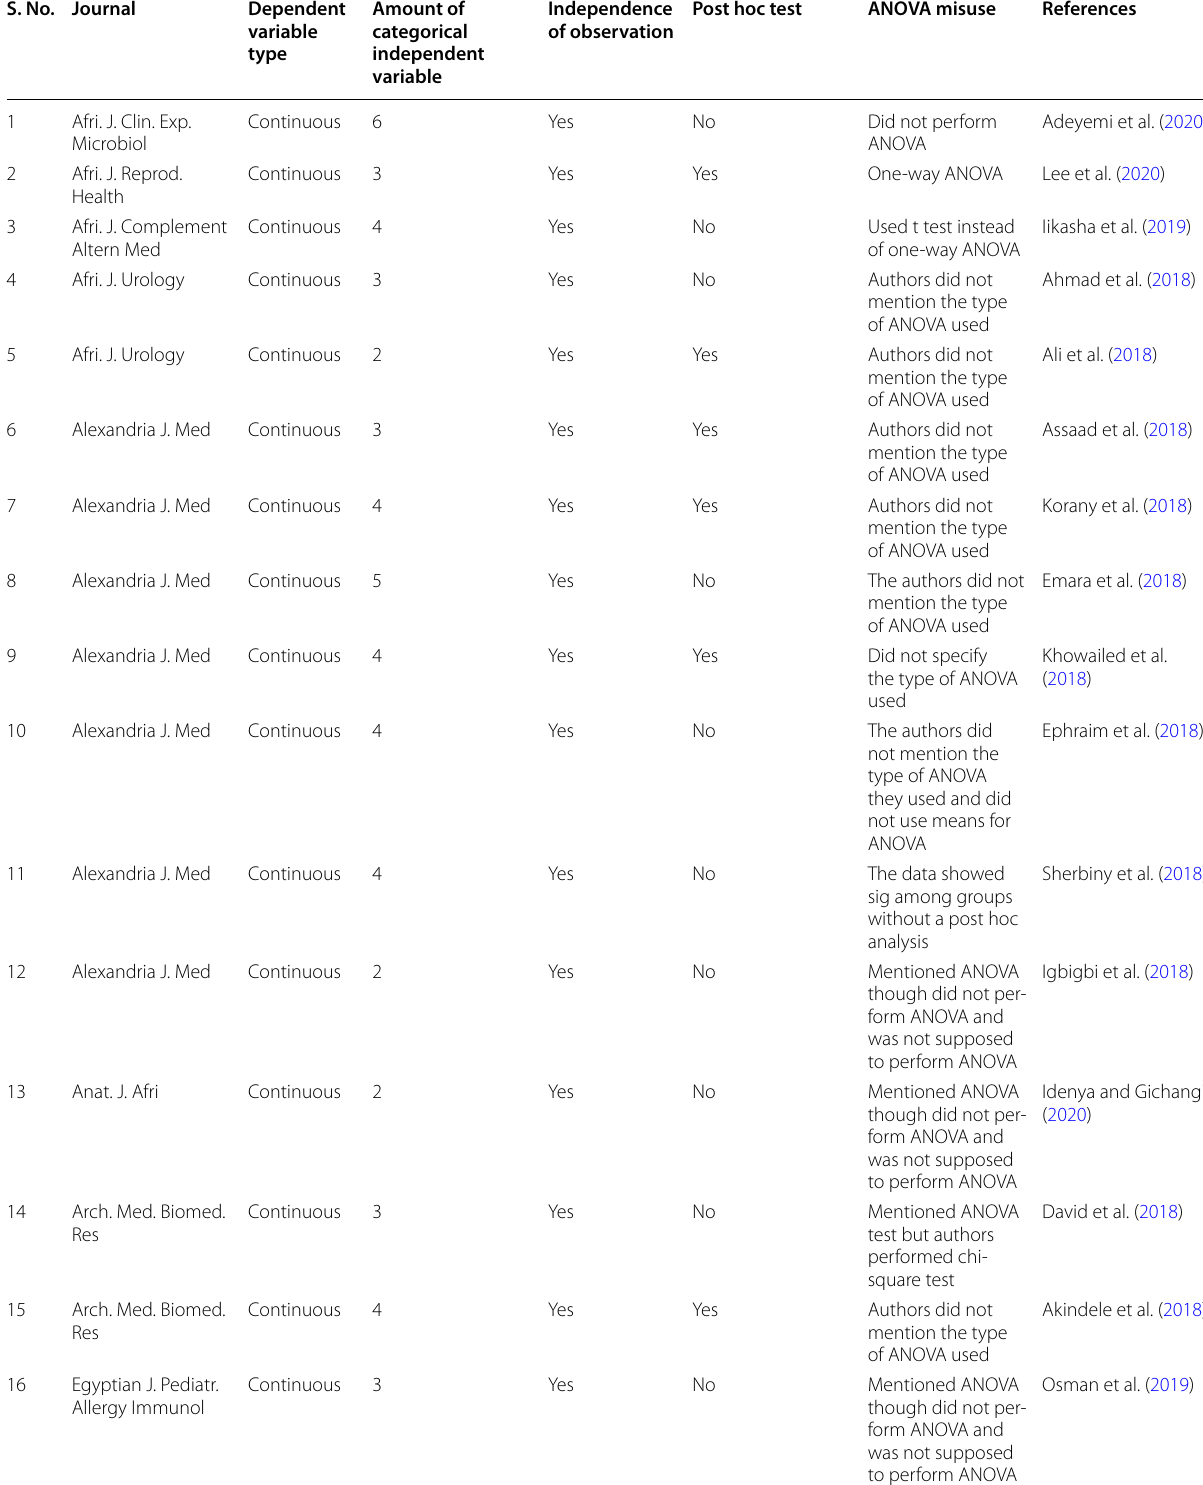
Table 1 Articles that misused ANOVA from the current issues of health-related journals published by the African Journals Online S. No.